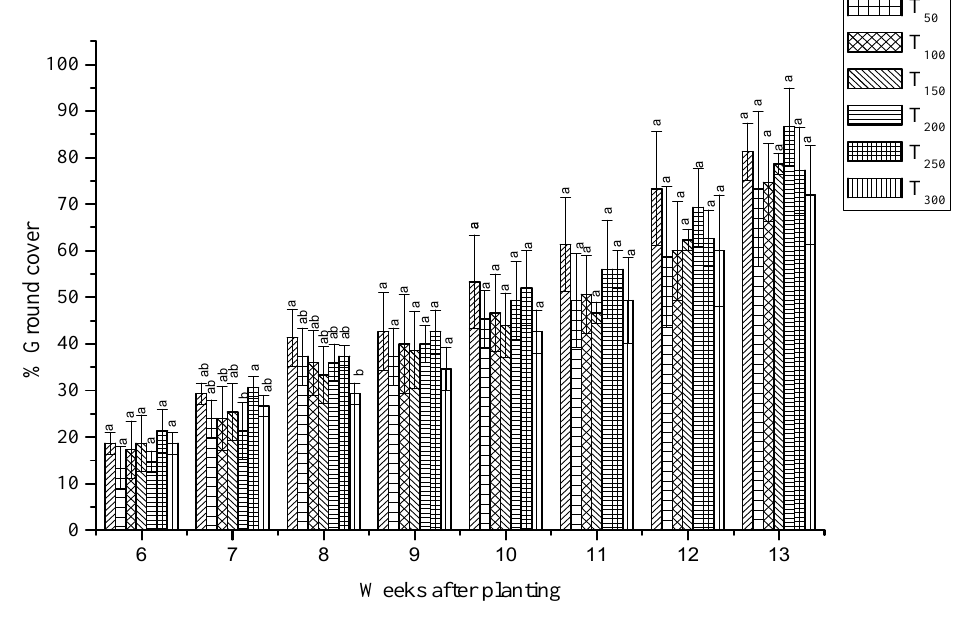
Figure 1: Percentage ground cover of C. aciculatus grown in soils contaminated with different concentrations of